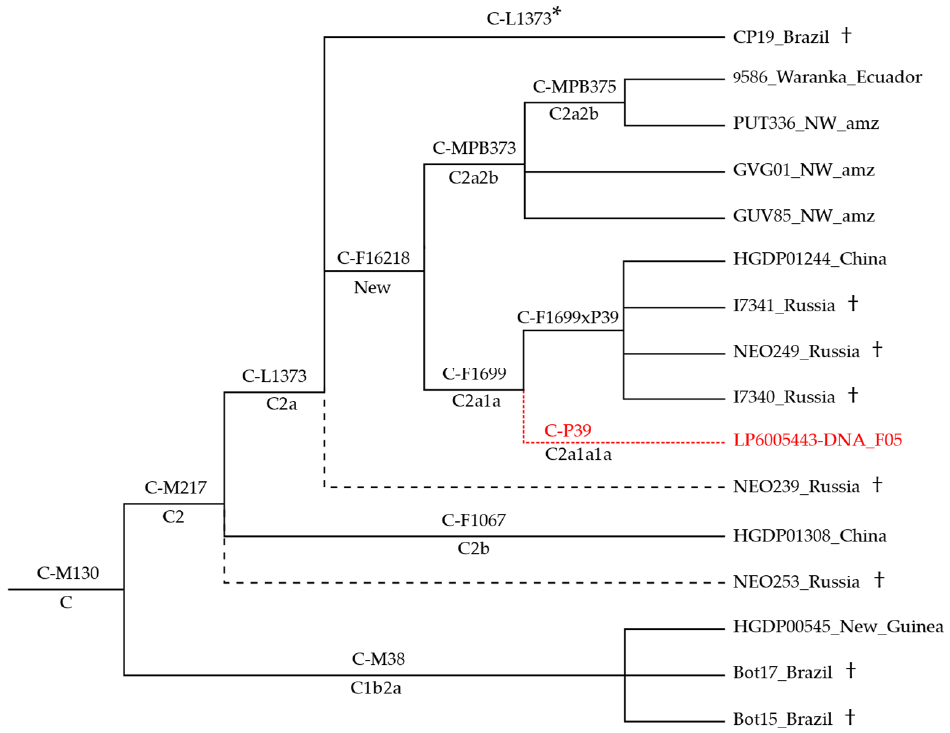
Figure 2. Phylogeny of haplogroup C sub-branches. C-L1373* identifies a Brazilian sample negative for the markers of all other C-L1373 derived branches; dashed black lines indicate less-well-defined samples (missing positions of informative downstream markers); (†) marks ancient samples. ISOGG nomenclature (http://www.isogg.org/tree/, accessed on 19 January 2022) is reported, when available; “New” indicate branches not reported. The placement of the North American C-P39 (in red) is inferred from Pinotti et al. [38].